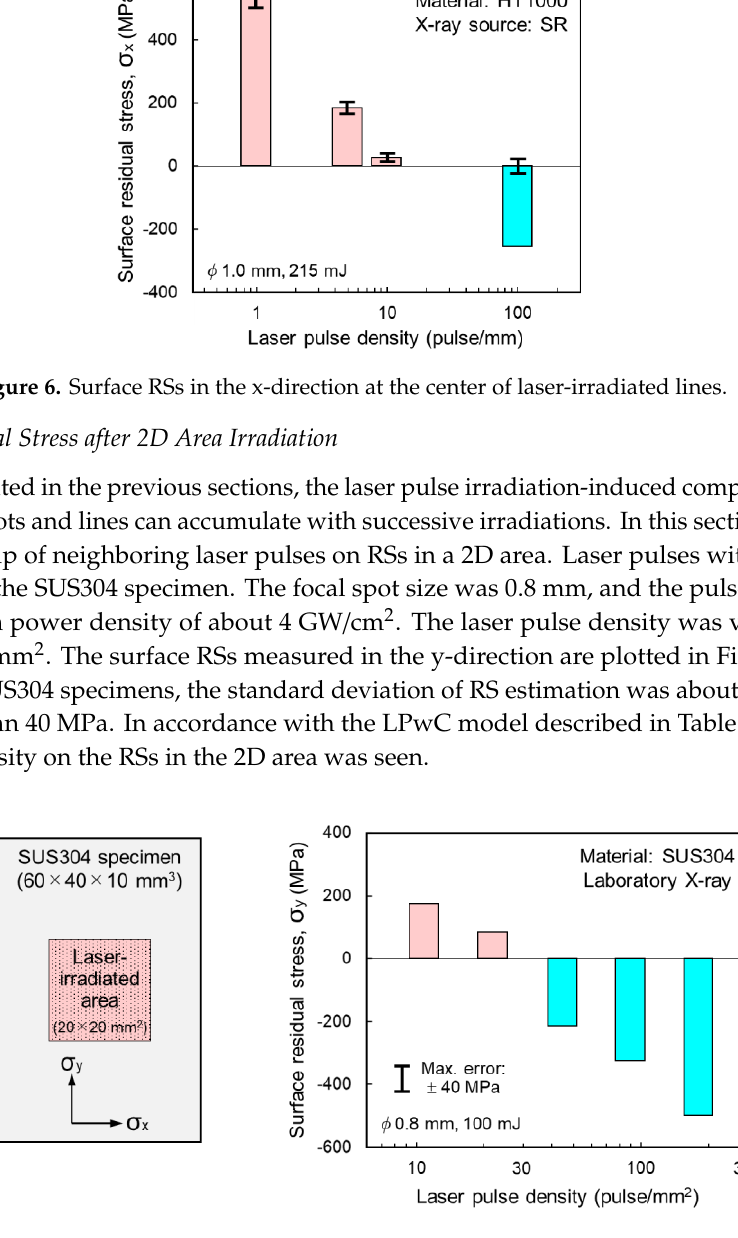
Figure 7. Surface RSs in the y-direction of areas irradiated with lasers differing in pulse density.